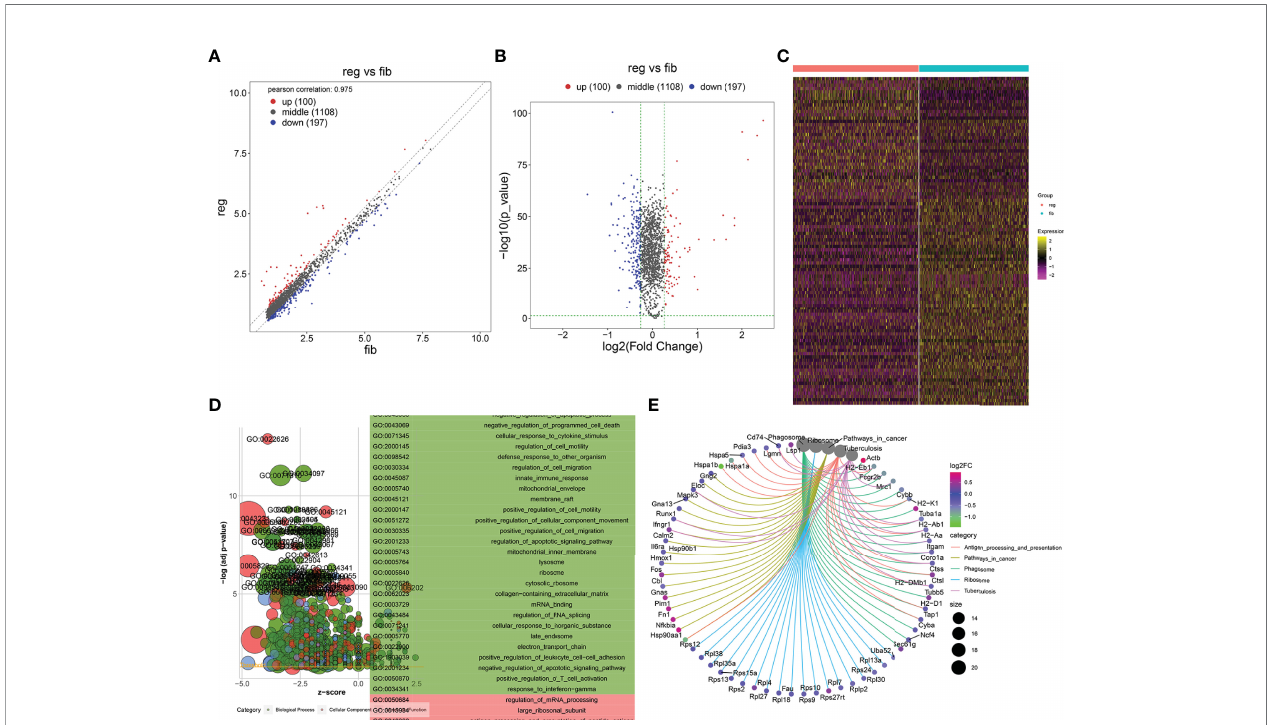
FIGURE 5 | Identi fi cation of speci fi c genes between fi brotic and regenerative macrophages and their biological functions. (A, B) Scatter plots and volcano diagram showing the up- and downregulated speci fi c genes in regenerative (reg) compared to fi brotic ( fi b) macrophages. Red dots meant upregulated genes while blue dots meant downregulated genes. (C) Heatmap visualizing the expression patterns of the speci fi c genes in fi brotic and regenerative macrophages. Yellow represented upregulation and purple represented downregulation. (D) GO enrichment results of speci fi c genes that were abnormally expressed between fi brotic and regenerative macrophages. (E) KEGG pathways involved in speci fi c genes that were abnormally expressed between fi brotic and regenerative